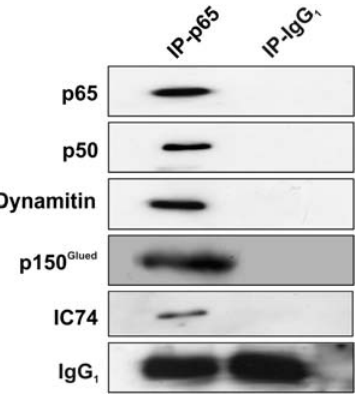
Figure 1. NF- k B exists in a complex with dynein/dynactin invivo. NF- k B p65 co-immunoprecipitates with dynactin and cytoplasmic dynein. 10 mg soluble rat brain extract were cross-linked with DSP to stabilize transient protein-protein interactions and subsequent immunoprecipi- tated with an anti-p65 antibody. Immunoprecipitates were analyzed by western blotting with an anti- NF- k B p65 or NF- k B p50 antibody or with antibodies against dynein intermediate chain (IC 74) or the motor- associated proteins dynamitin and p150 Glued . Control IP was done with a non-immune monoclonal antibody.